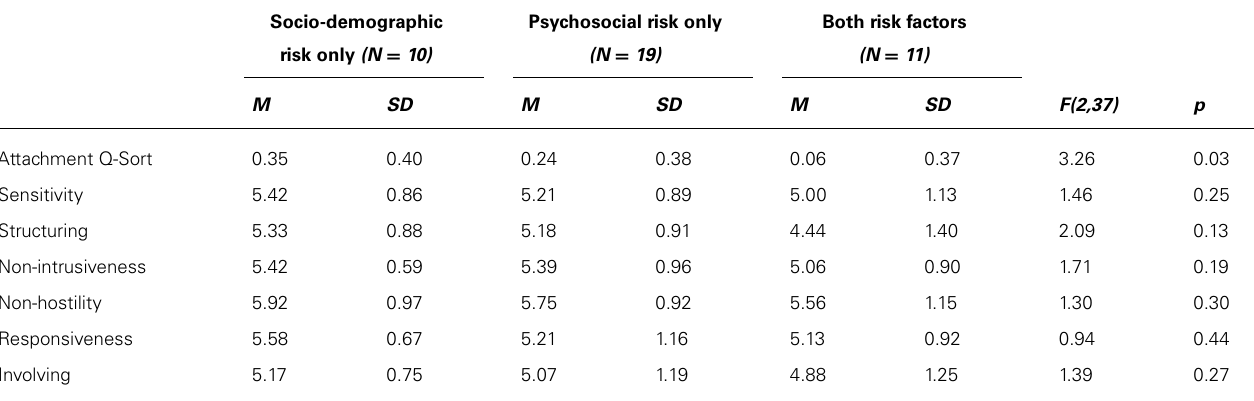
Table 2 | Descriptive and inferential statistics forAttachment Q-Sort and EmotionalAvailability Scales scores for type of risk factors. Socio-demographic